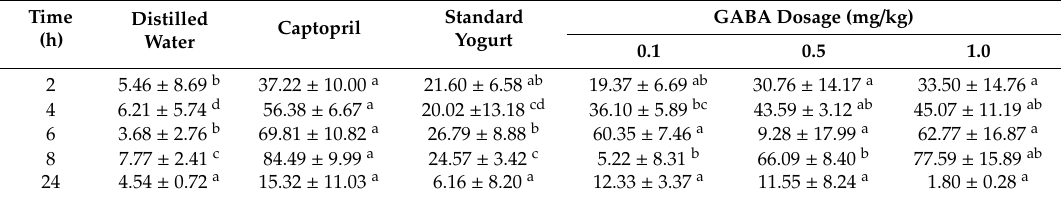
Table 3. Di ff erence in systolic blood pressure (mmHg) in spontaneously hypertensive rats after single oral administration of